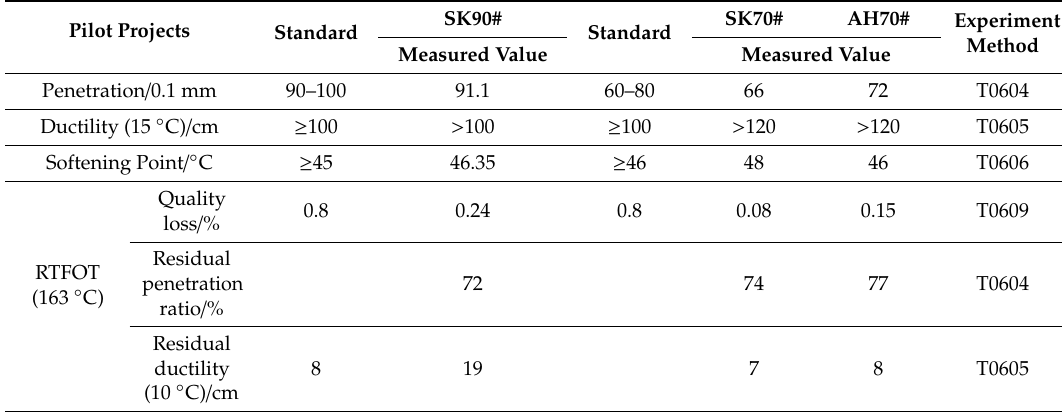
Table 1. Main property of the matrix asphalt.